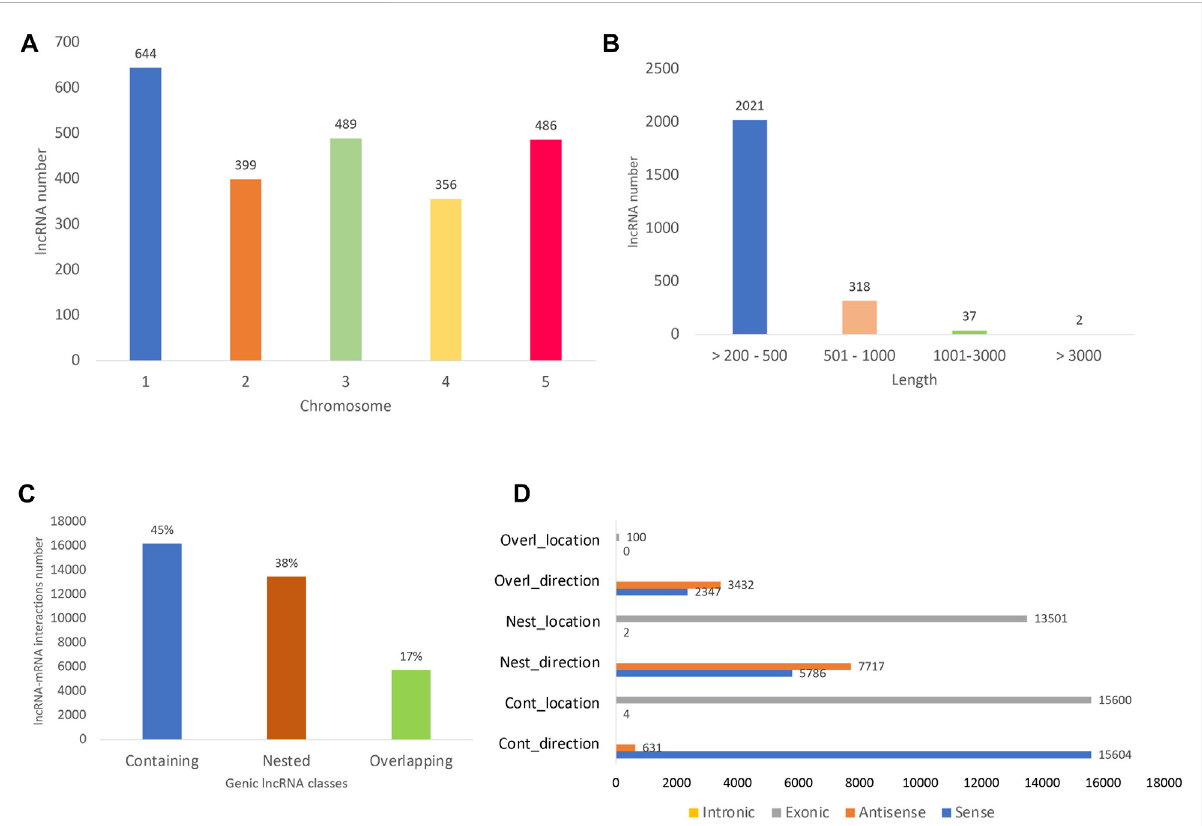
Long noncoding RNA (lncRNA) distribution. (A) Number of long noncoding RNAs already known (with AT identi fi ers) along the fi ve A. thaliana chromosomes. (B) LengthofalllncRNAidenti fi ed,includingthosewithATidenti fi ersandnovelones(theisoformswerenotconsideredinthecount). (C) Distribution of lncRNA and their respective differentially expressed protein-coding gene (PCG) targets. The interacting lncRNA – DEmRNA pairs werelocated mostly ingenicregions (99.8%) and distributed inthefollowingsubtypes: containing (lncRNA contains themRNApartner),nested (lncRNA is contained in the mRNA partner), and overlapping (lncRNA partially overlaps PCG partner). (D) lncRNA – PCG interaction direction and location, being mostly in sense direction and located in exonic regions. The x -axis shows the number of interactions detected and the y -axis